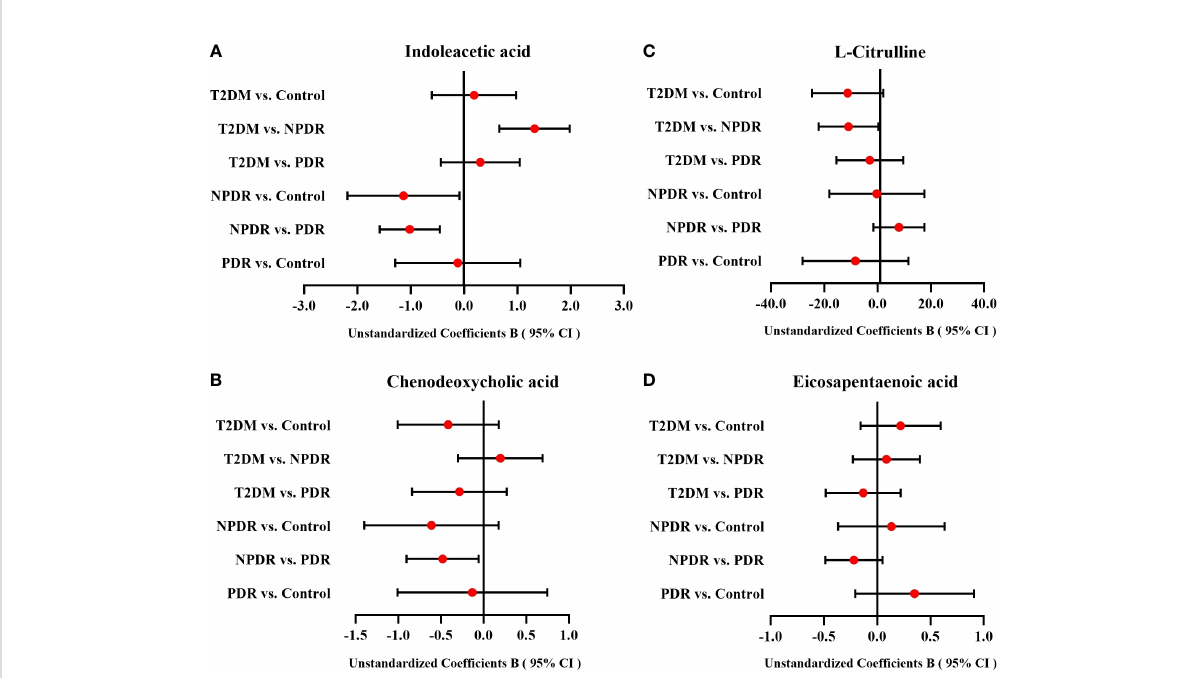
FIGURE 7 The forest plots of IAA, CDCA, Cit and EPA among groups. After multiple linear regression analyses of age, diabetes duration, FPG and HbA1 for differential metabolites between groups, (A) the serum level of IAA between T2DM group and NPDR group, NPDR group and control group, and NPDR group and PDR group were statistically signi fi cant, (B) the serum level of CDCA between NPDR group and PDR group was also statistically signi fi cant, and (C) the serum Cit level between T2DM group and NPDR group was of borderline statistical signi fi cance. (D) The serum levels of EPA which showed no statistically signi fi cant difference among the groups. CI, con fi dence interval; T2DM, type 2 diabetes mellitus; NPDR, non- proliferative diabetic retinopathy; PDR, proliferative diabetic retinopathy; Cit, L-Citrulline; IAA, Indoleacetic acid; 1-MH, 1-Methylhistidine; CDCA, Chenodeoxycholic acid; EPA, Eicosapentaenoic